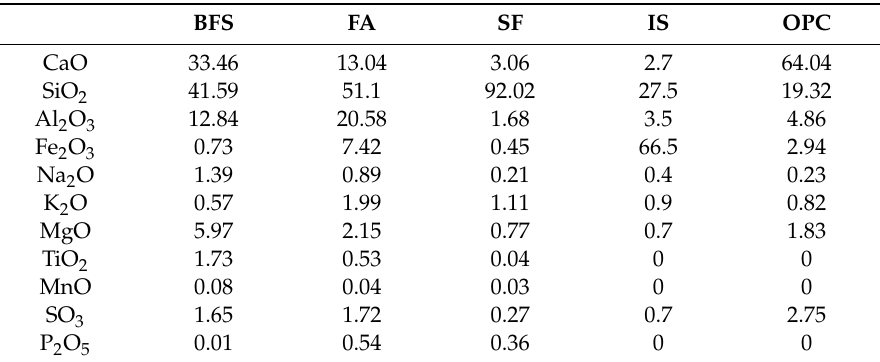
Table 1. Chemical composition of the used materials.